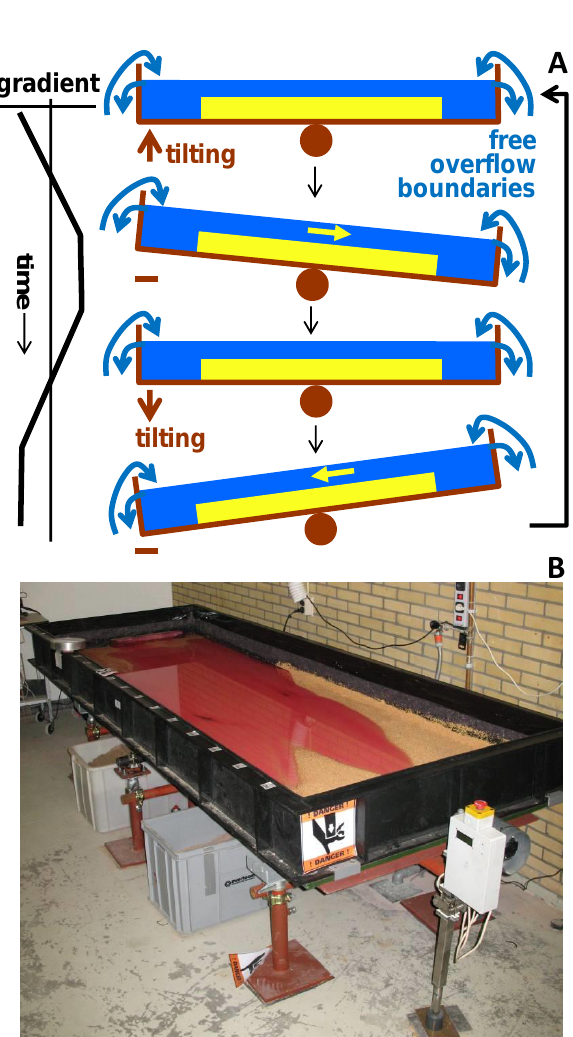
Fig. 1. Tilting flume to create bidirectional tidal currents and sediment transport. A. Schematic drawing showing the principle. B. Photograph of the flume in a similar experiment. The flume width is 1.3m. Amplitude, constant tilting speed and delay between al- ternating tilting directions are adjustable (leg with stepping motor in bottom right). Fixed free overflow boundaries ensure a constant